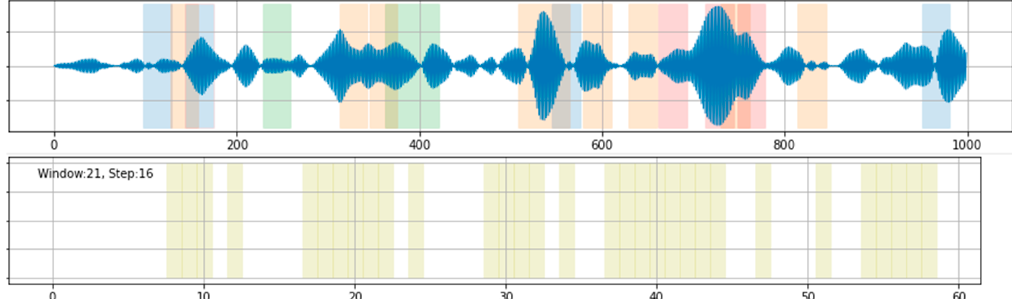
Figure 8. Classification results from k -means with various window sizes of ~10 m and step sizes of 1 s for k = 3.